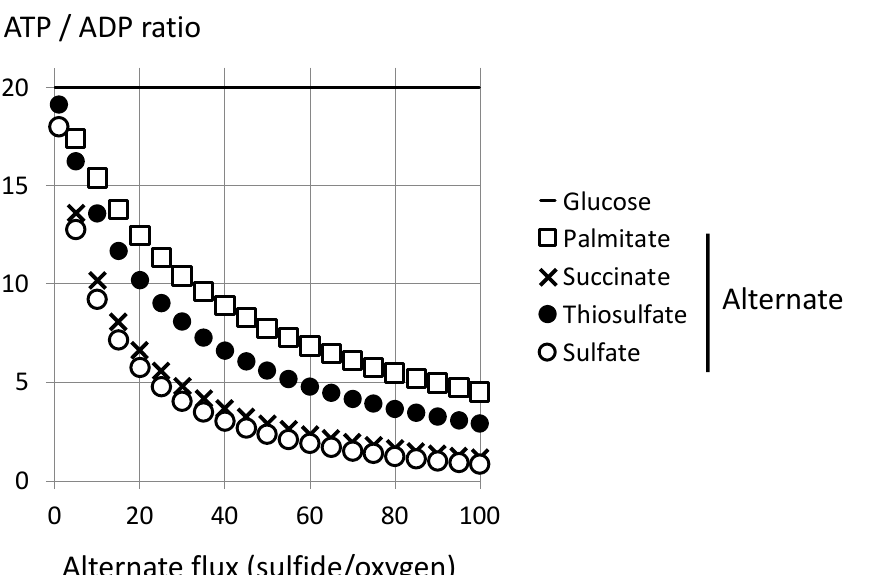
Figure 10. Impact of sulfide oxidation under respiratory chain limitation. The model states that the number of reactions in the mitochondrial respiratory chain is the limiting factor. Then the calculation considers 100 reactions in respiratory complexes III and IV (thiosulfate) or 50 in complex III and 100 in complex IV (sulfate see Figure 6). Rest of the legend as above. With regard to Figure 9, it modifies Y values for sulfide curves only; another consequence is the increase of the maximal X value (100) for oxidation of sulfide into sulfate.